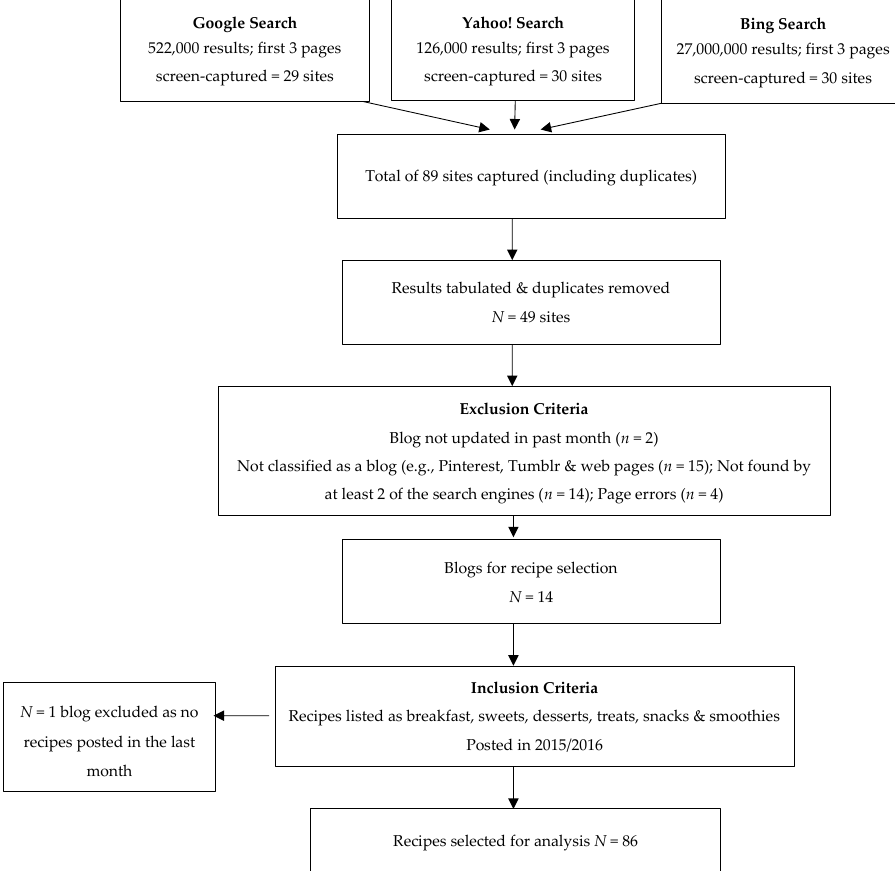
Figure 1. Flowchart of the process of blog and recipe selection. 111